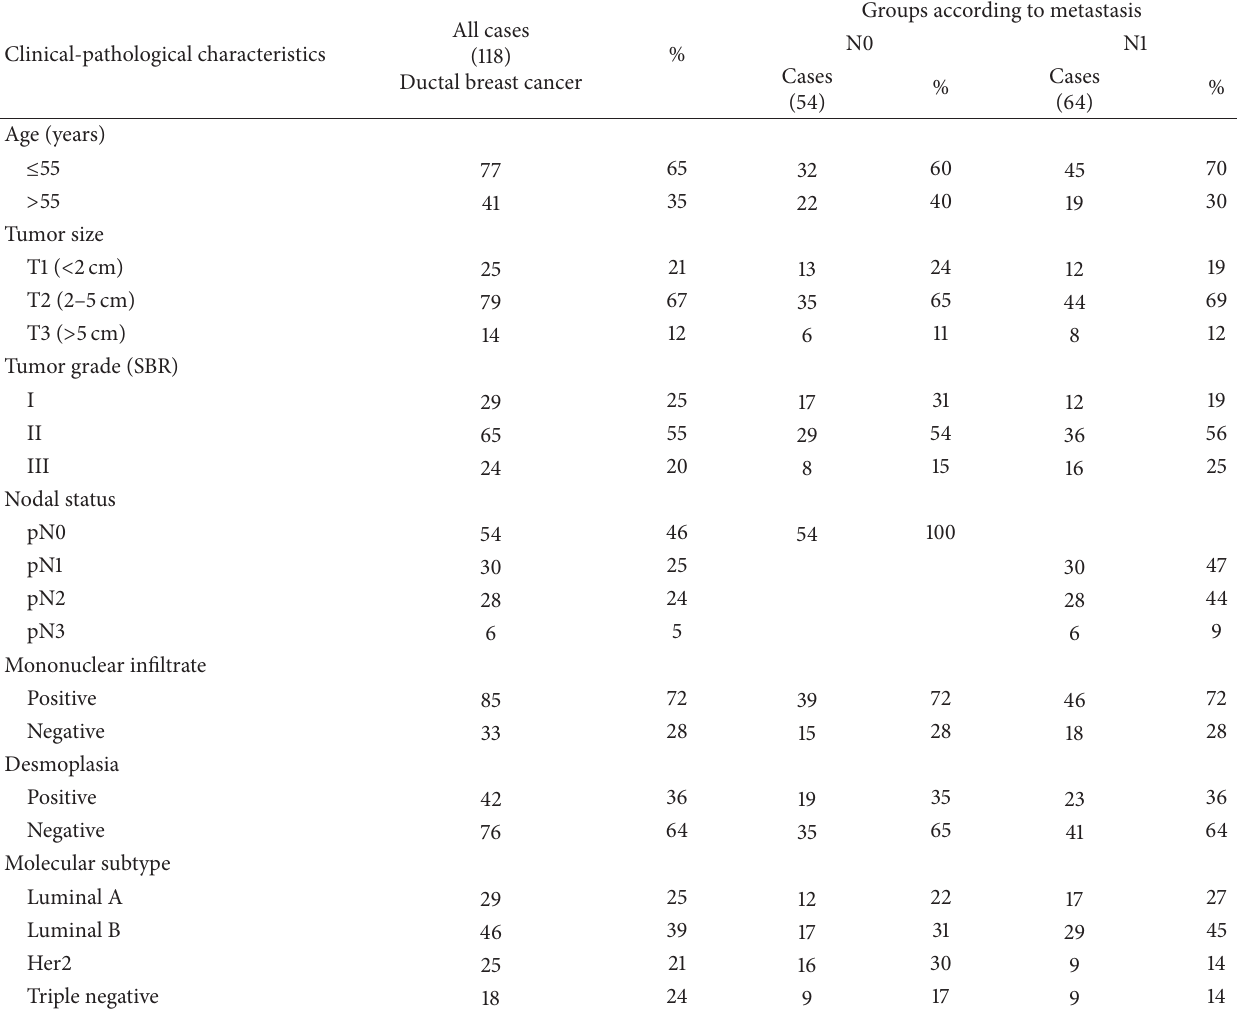
Table 1: Clinical and pathological characterization of breast cancer patients participating in the